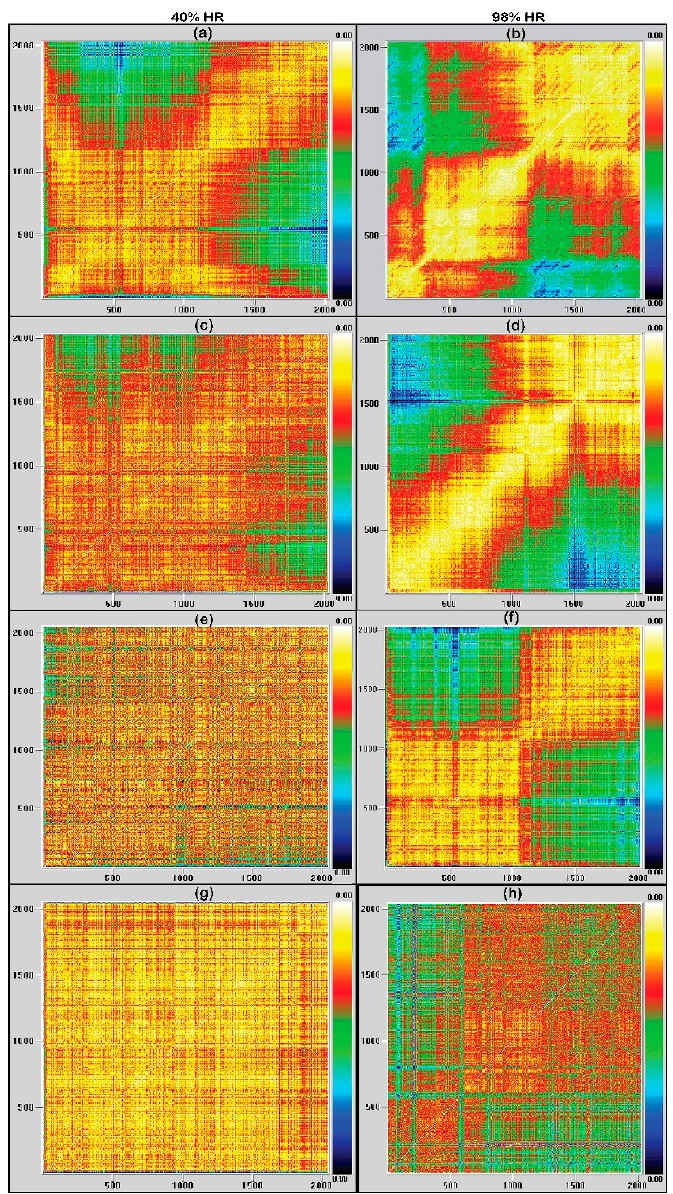
Figure 7. Recurrence plots of ( a ) Blank at 40% RH, ( b ) blank at 98% RH, ( c ) Paraloid B72 at 40% RH, ( d ) Paraloid B72 at 98% RH, ( e ) Paraloid B72 + μ g ∙ cm − 2 of caffeine at 40% RH, ( f ) Paraloid B72 + 50 μ g ∙ cm − 2 of caffeine 98% at RH, ( g ) Paraloid B72 + 50 μ g ∙ cm − 2 of nicotine at 40% RH, and ( h ) Paraloid B72 + 50 μ g ∙ cm − 2 of nicotine at 98% RH.